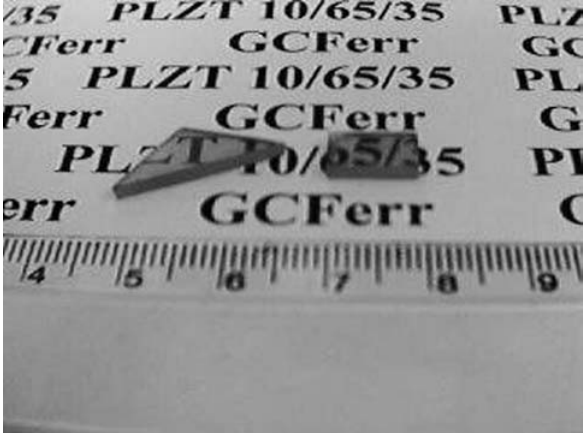
Figure 1. Hot-pressed PLZT 10/65/35 ceramics. Figure 2. X-ray diffraction pattern of the PLZT 10/65/35